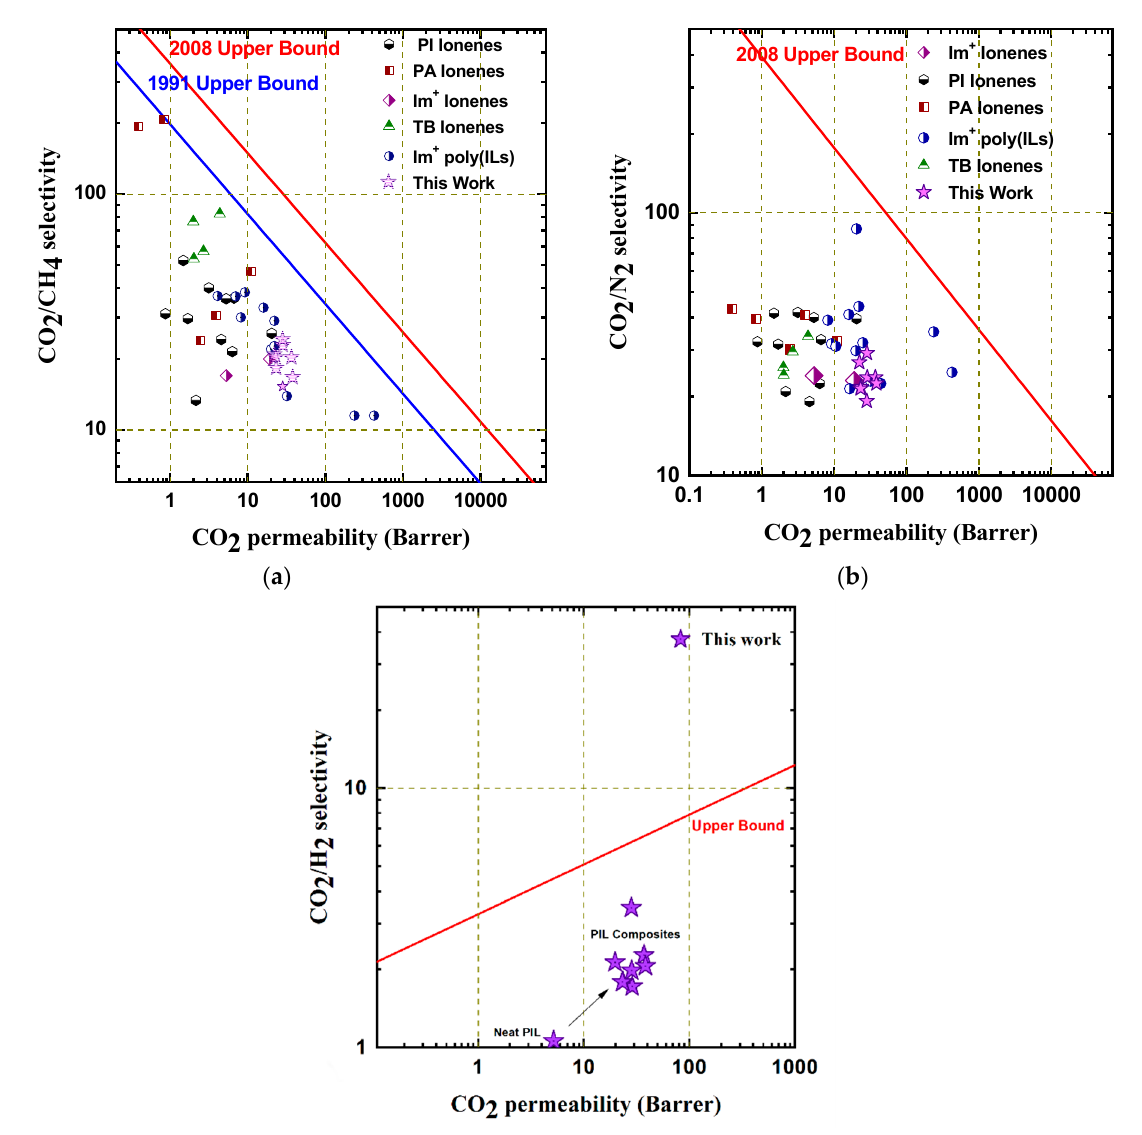
Figure 7. Robeson plots depicting the CO 2 selectivity against N 2, CH 4, and H 2 for the PIL:IL-filled membranes in this work for comparison with relevant membrane materials [4,26,28,37,39–41,43–45]. ( a ) α CO2/CH4 vs. P CO2 ; ( b ) α CO2/N2 vs. P CO2; ( c ) α CO2/H2 vs. P CO2.